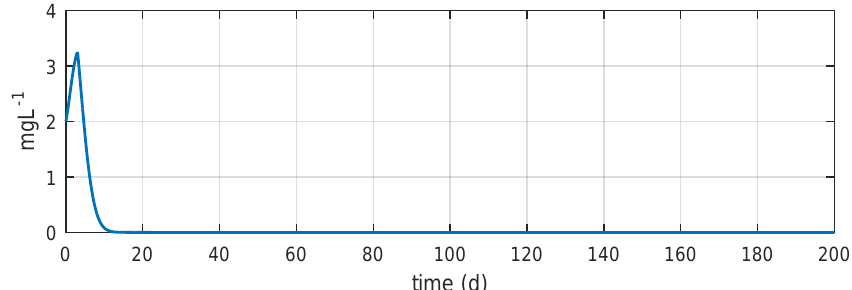
Figure 19. Methanogenic biomass concentration x m in the MEC.